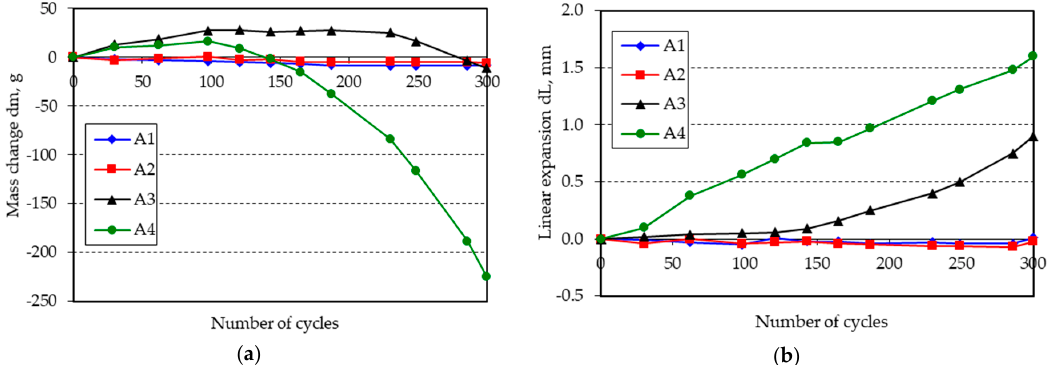
Figure 1. ( a ) Mass change; ( b ) linear expansion of specimens A1–A4 following freezing and thawing in water.